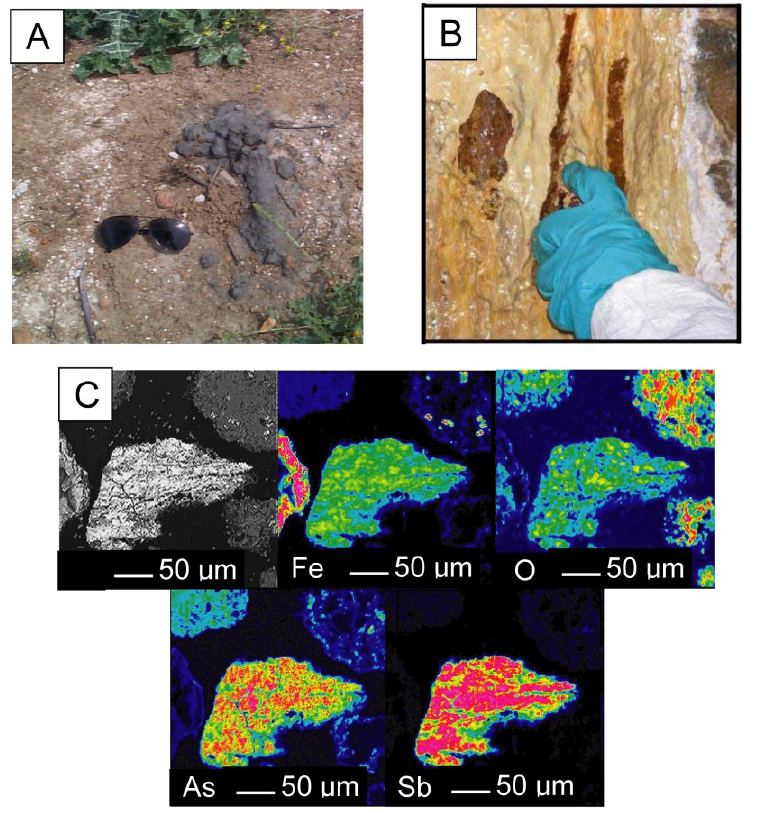
Figure 1. Examples of As-bearing minerals in mine wastes. ( A ) Tailings from the 1998 Aznalcóllar (Spain) tailings dam spill that contain arsenopyrite, described in [5]. ( B ) Microbial biofilm sampled from Giant Mine, Yellowknife, NWT, Canada. The mineral yukonite, a Ca-Fe arsenate, is shown by the reddish-brown coloration. From [11]. And ( C ) Electron microprobe X-ray map of secondary Fe-As-Sb-O phase in solids from Bolivian tailings weathering column experiments. Reprinted with permission from [2], Mineralogical Society of Great Britain &